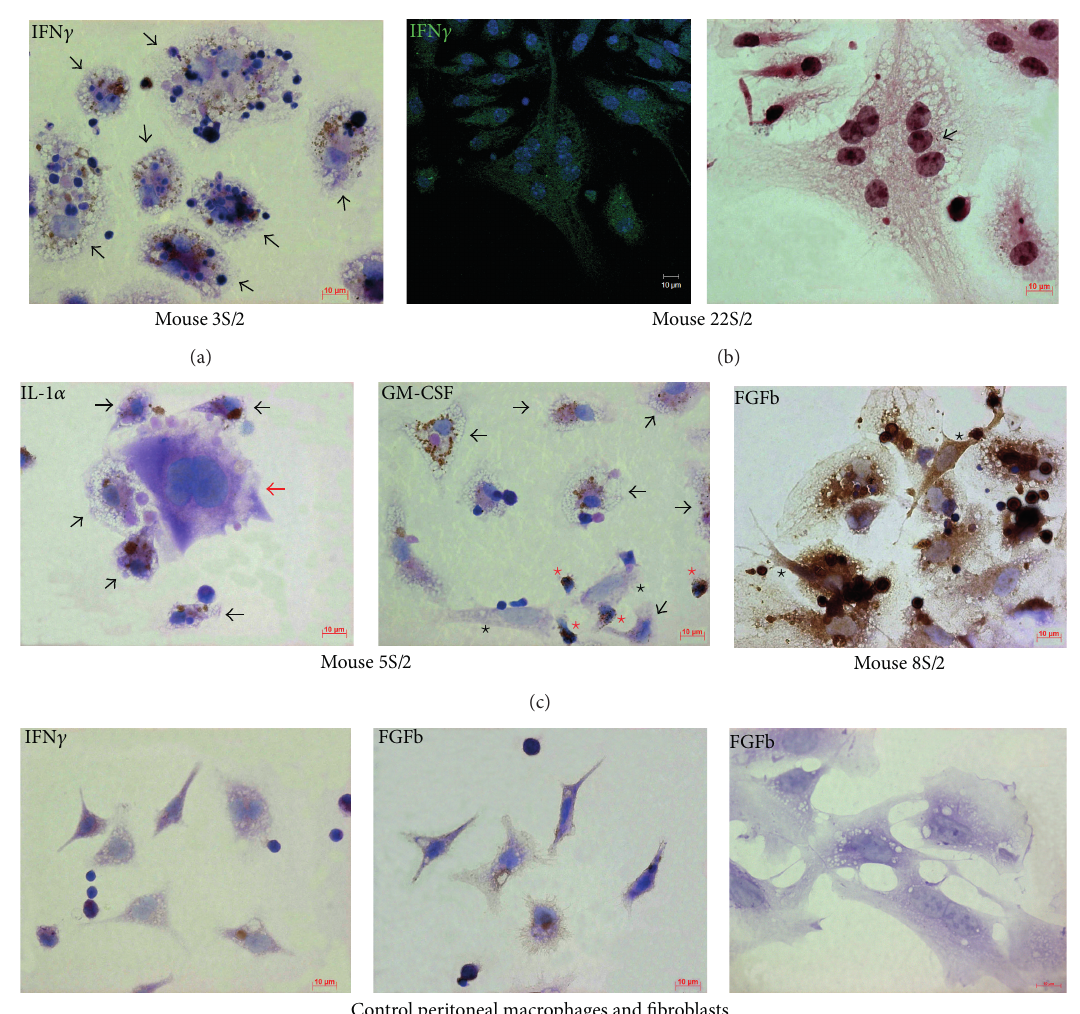
Figure5:IFN 𝛾 ,IL-1 𝛼 ,GM-CSF,andFGFbingranulomacellsfromthespleens(S/)ofmicethatwereinfectedwiththeBCGvaccine in vivo for two months (/2) and after ex vivo culture for a few days. Scale bars: 10 𝜇 m. Detailed pictures of granulomas. ((a), (c)-(d)) Immunochemical localization of cytokines in granuloma cells ((a), (c)) and control mouse peritoneal macrophages ((d), left and central panels) and spleen fibroblasts ((d), right panel). The brown color of the cell membranes indicates the presence of cytokines in these regions. Black arrows indicate macrophages stained for (a) IFN 𝛾 , (c) IL-1 𝛼 , and GM-CSF. (c) Red arrow indicates megakaryocyte; red stars indicate neutrophils with GM- CSF; black stars indicate fibroblasts without GM-CSF and with FGFb. (b) Confocal immunofluorescent localization of IFN 𝛾 (green signal) in granuloma cells. Staining nuclei with DAPI (blue signal). On the right panel is the same granuloma part as on the left panel but restained to acid-fast BCG-mycobacteria with Ziehl-Neelsen stain. BCG-mycobacterium in a Langhans giant cell is indicated by black